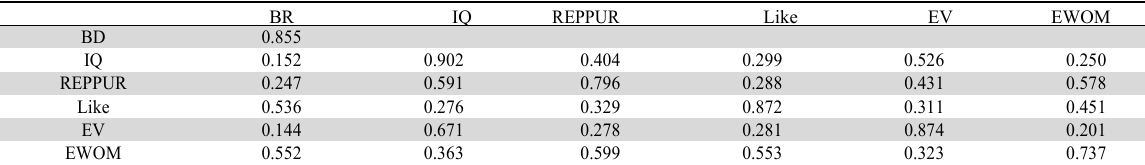
Fornell-Larcker scale